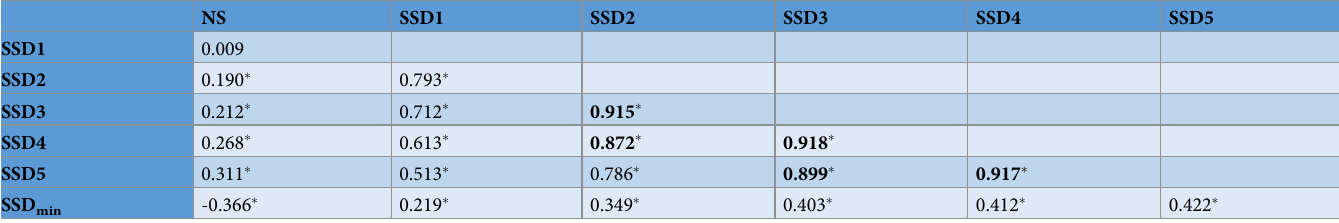
Results based on 609 rolls belonging to 41 individuals. Pearson’s r coefficients are given. (cid:3) —correlation is significant at the 0.01 level.